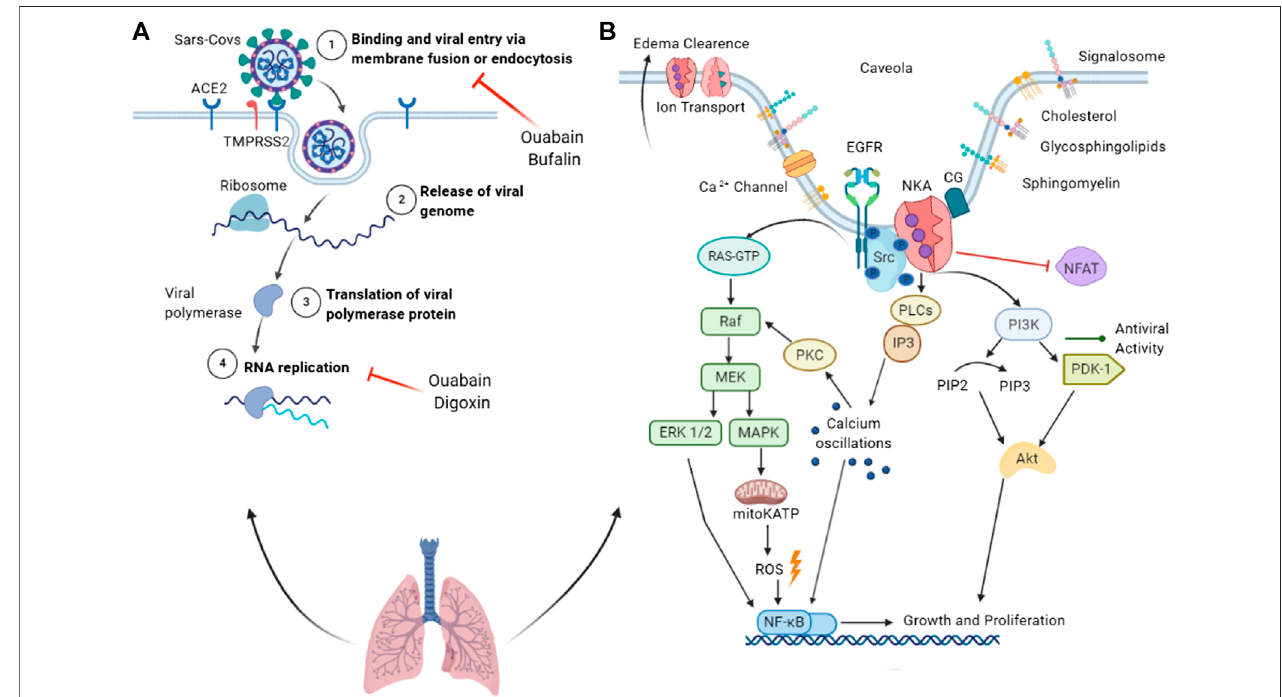
FIGURE 1 | Summary of the antiviral properties of cardiac glycosides and Na+/K+-ATPase as a signal transducer. (A) Binding of SARS-CoV spike protein to the ACE2 receptor leads to membrane fusion or endocytosis, a process inhibited by ouabain and bufalin (1). Once in the cytoplasm, the viral genome is released (2) and translated into replicase proteins. The polyproteins are cleaved by a virus protease into individual replicase complex nonstructural proteins (nsps) (3), forming the replication-transcription complexes where replication begins (4). (B) Na+/K+-ATPase acts in ion transport, edema clearance, and as a signal transducer. Cardiac glycoside binding to the preassembled Na+/K+-ATPase (pump) signalosome in caveolae transduces signals via multiple pathways. Activated NKA rapidly activates Src tyrosine kinase, which activates the EGFR. Activated EGFR recruits protein adaptors that activate the Ras-GTP complex, leading to MEK pathway activation. MAPK activationtriggerstheopeningofmitochondrialATP-sensitivepotassiumchannels(mitoKATP),resultinginROSproductionandNF κ Bactivation.TheMEKpathwayalso activates NF κ B through ERK ½ activation. In parallel, Src modulates the activation of the PI3K/PDK1 pathway, which is associated with viral activity and replication suppression. Activated PI3K phosphorylates Akt, which phosphorylates a variety of downstream pathways related to growth, survival, and proliferation. NKA activates phospholipaseC(PLC)and inositol-1,4,5-triphosphate (IP3);thelatter bindstotheIP3receptor oftheendoplasmic reticulum, releasing calciumionsintothecytoplasm. Calcium oscillation activates PKC and NF κ B. ACE2, angiotensin-converting enzyme 2; TMPRSS2, transmembrane protease serine 2; Src, non-receptor tyrosine kinases; EGFR, epithelial growth factor receptor; PKC, protein kinase C; PI3K, phosphoinositide 3 ′ kinase; PLC, phospholipase C; MAPK, mitogen-activated protein kinase; MEK, MAPK – ERK activating kinase; ROS, reactive oxygen species; mitoKATP, mitochondrial ATP-sensitive potassium